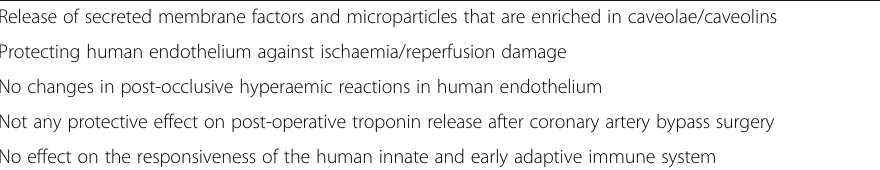
Table 2 Effects of helium in ischemic human tissue Release of secreted membrane factors and microparticles that are enriched in caveolae/caveolins Protecting human endothelium against ischaemia/reperfusion damage No changes in post-occlusive hyperaemic reactions in human endothelium Not any protective effect on post-operative troponin release after coronary artery bypass surgery No effect on the responsiveness of the human innate and early adaptive immune